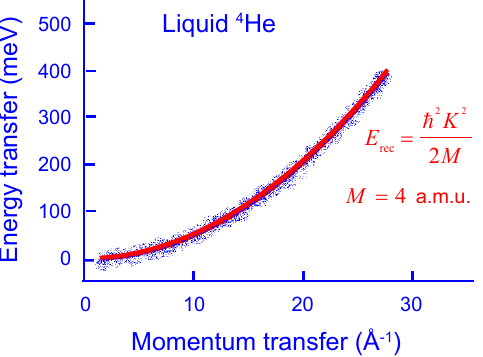
Figure 2. Schematic representation (blue points) of the dynamic structure factor S ( K , E ) of liquid helium, adapted from Ref. [18]. The experiment was performed with the 2-dimensional TOF- spectrometer ARCS [19]. Red line: The calculated recoil parabola, Equation (10), for the mass of 4 He. The data are fitted with the recoil parabola with M = 4 a.m.u. excellently. (Figure taken from Ref. [11] with permission of